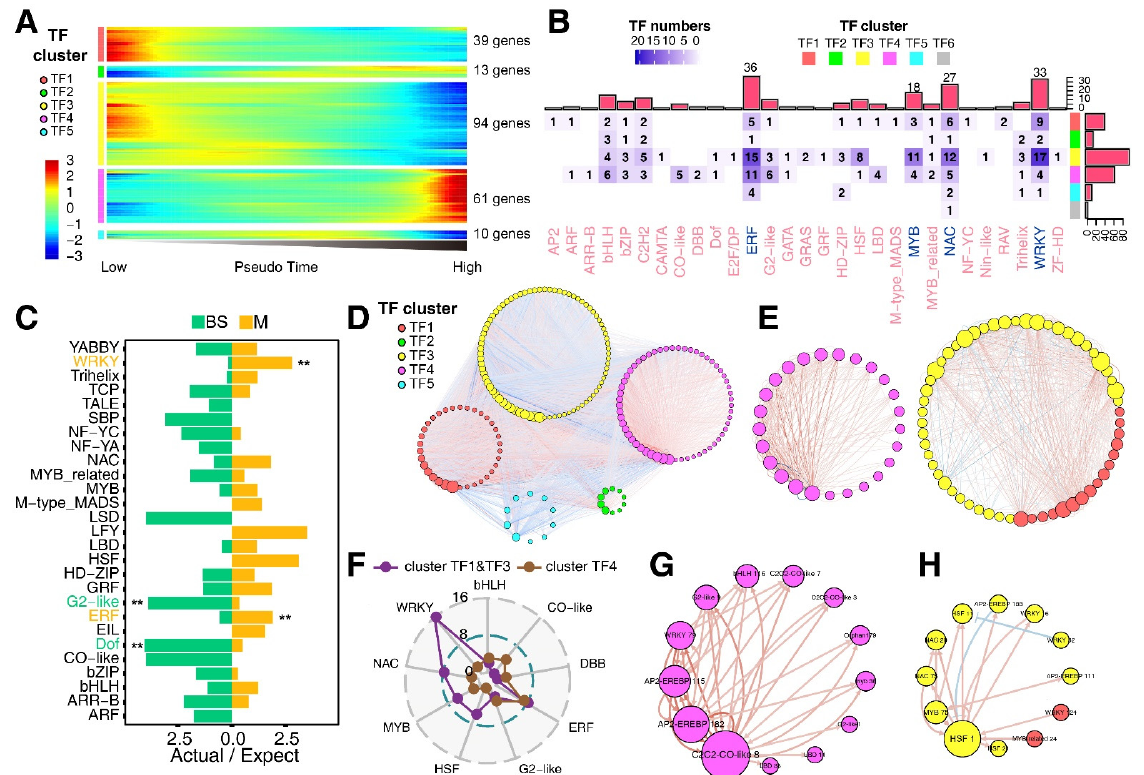
Figure 4. Identification of key transcription factors in M-cell development. ( A ) Heatmap showing the expression profiles of 217 highly dynamically expressed TFs ordered across pseudo-time in the 5 clusters. ( B ) Heatmap showing the number of TFs associated with different families in different gene clusters, the annotation bar plots on the top and the right of the heatmap show the numbers of TFs related to different families and clusters. ( C ) Bar plots showing the ratio of actual to expected numbers of TFs related to different families in M and BS cells. Significance test was determined for the ratios between M and BS cells (two-sided chi-squared test, ** indicates p < 0.01). ( D ) SCODE network displaying 191 dynamically expressed TFs with a cutoff as 0.1 during M-cell development. ( E ) SCODE network filtered with edge overlapping WGCNA network across M-cell development with a cutoff of 0.5, representing TFs involved in the early and the late stage of the leaf development. ( F ) Radar plot showing the TF numbers related to different families in Cluster TF1 and TF3 and Cluster TF4 network. ( G ) SCODE network filtered with edge overlapping WGCNA network across M-cell development with a cutoff of 0.5, representing TFs involved in the early stage of leaf development. ( H ) SCODE network filtered with edge overlapping WGCNA network across M-cell development with a cutoff of 0.5, representing TFs involved in the late stage of leaf development. The size of the node in all SCODE networks indicates the degree of the